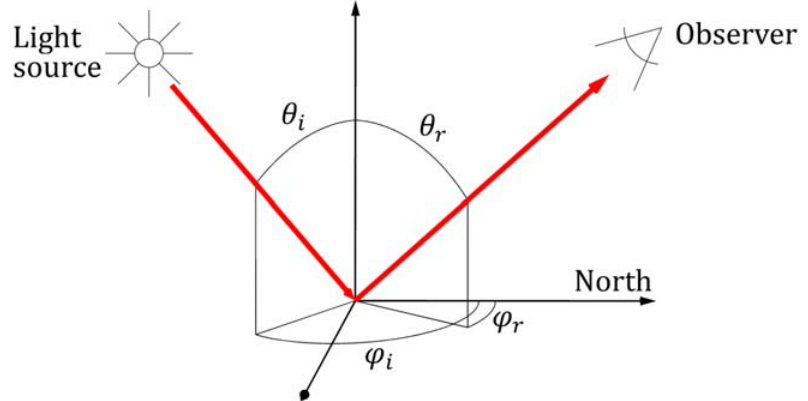
Figure 1. Bidirectional reflectance geometry. θ and azimuth angles of incident (i) and reflected (r)